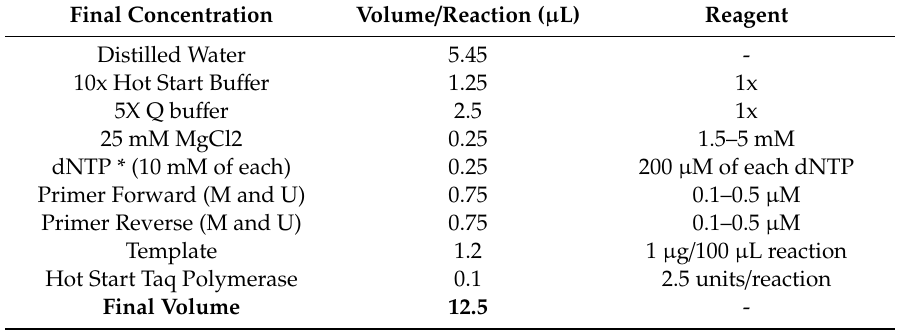
Table 1. Reagents and volumes utilized for preparing the polymerase chain reaction (PCR) master mix.